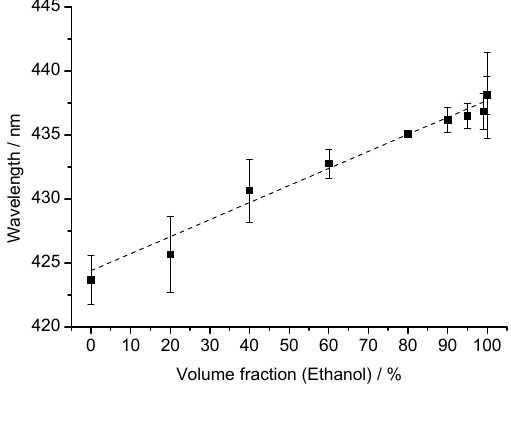
Figure 5. Effect of the fraction of ethanol in methanol on the peak wavelength of reflected light of polystyrene nanoparticles in polydimethylsiloxane. Each data point represents the average value of five measurements with the same PCCA film, and the error bars indicate the standard deviation.